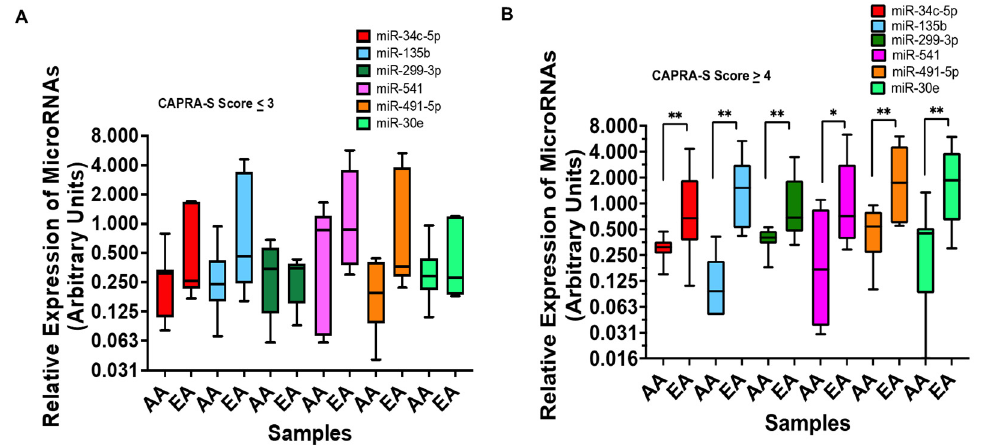
Figure 4. Top miRNAs with differential regulation between European American (EA) and African American (AA) men: ( A , B ) the fold change in expression of AR-regulating miRNAs grouped by race. Patients with CAPRA-S scores lower than 3 ( A ) and greater than 3 ( B ) are presented ( p values: * <0.07, ** <0.05.